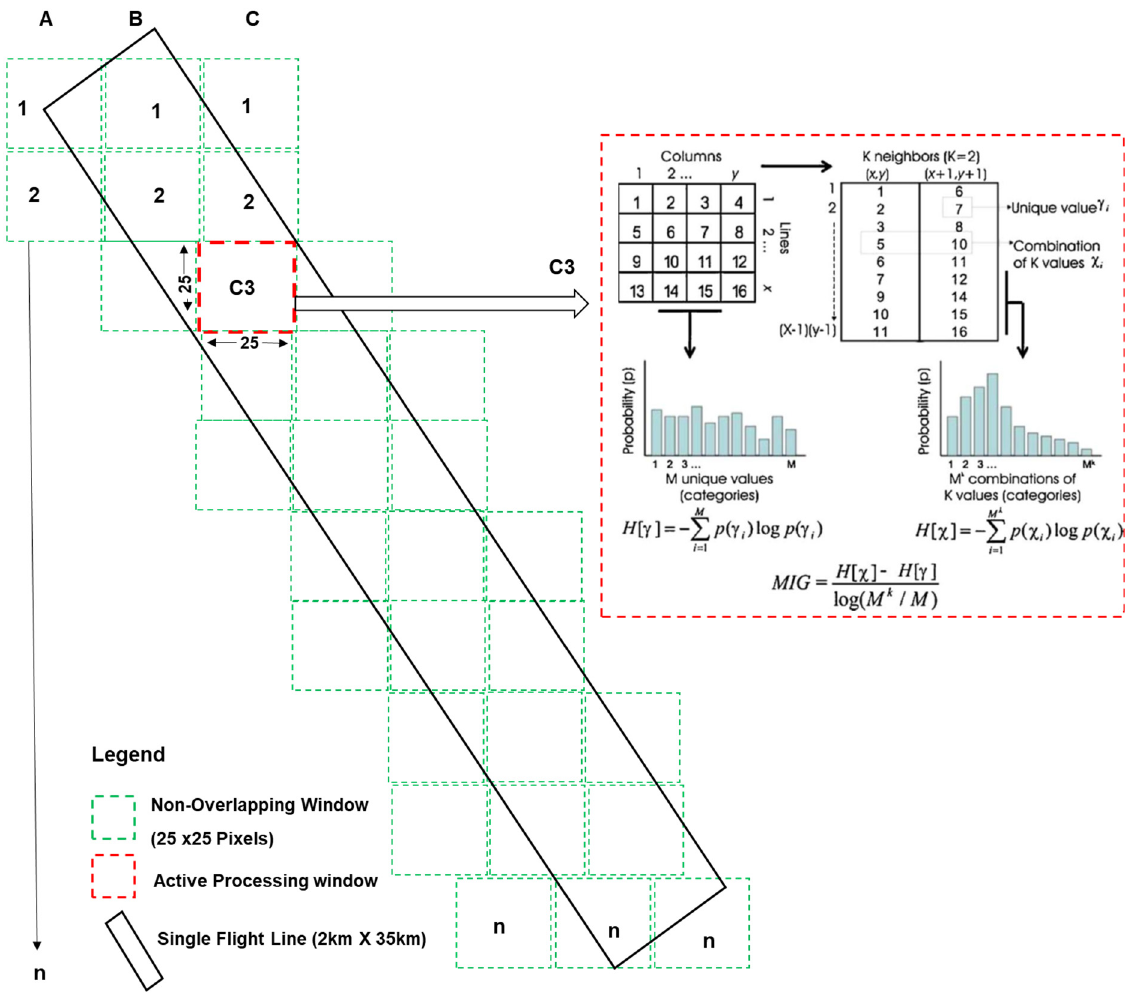
Figure 3. Schematic diagram showing the non-overlapping window approach adopted in the implementation of spectral complexity metrics on hyperspectral imagery. The non-overlapping window outlines are not drawn to scale. Red dashed lines show an active processing window with a diagram showing an example of the MIG (k = 2) computation reprinted from Ecological Indicators, 9/1248–1256, Raphaël Proulx, Lael Parrott, Structural complexity in digital images as an ecological indicator for monitoring forest dynamics across scale, space and time, page 1251, Copyright (2009), with permission from Elsevier.